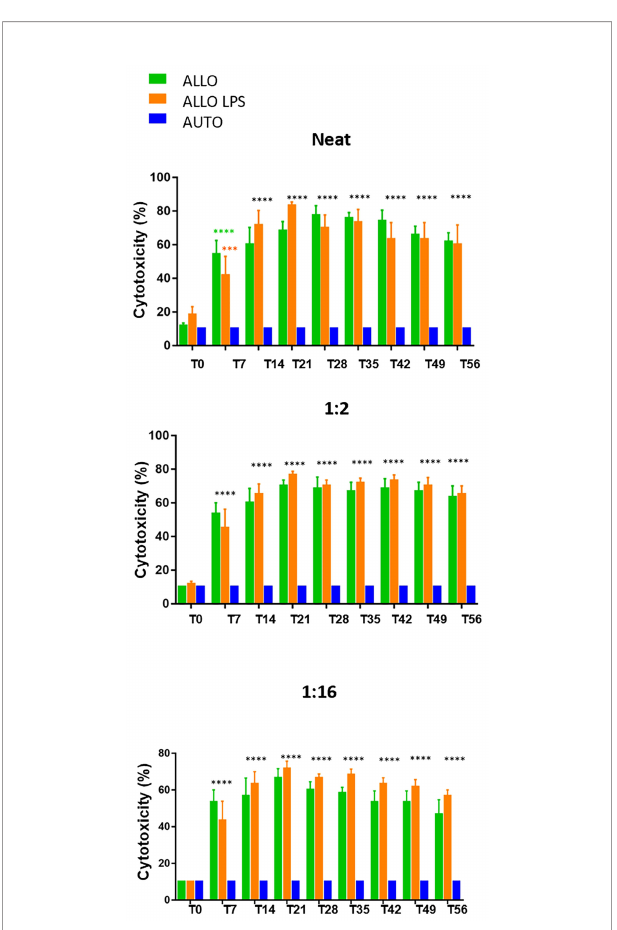
FIGURE 9 | Microcytotoxicity assay before and after synovial membrane mesenchymal stem cell injections in neat, 1:2 and 1:16 sera dilutions. Initial time point did not reveal antibody production. However, comparison between T0 and T7 revealed P<0.0001(****) in neat serum of ALLO group and P=0.0038 (***) in ALLO LPS group. Subsequent time points showed signi fi cant antibody production in ALLO and ALLO LPS groups, from T14 to T56 (****P<0.0001) in all sera dilutions. No differences were observed between ALLO and ALLO LPS